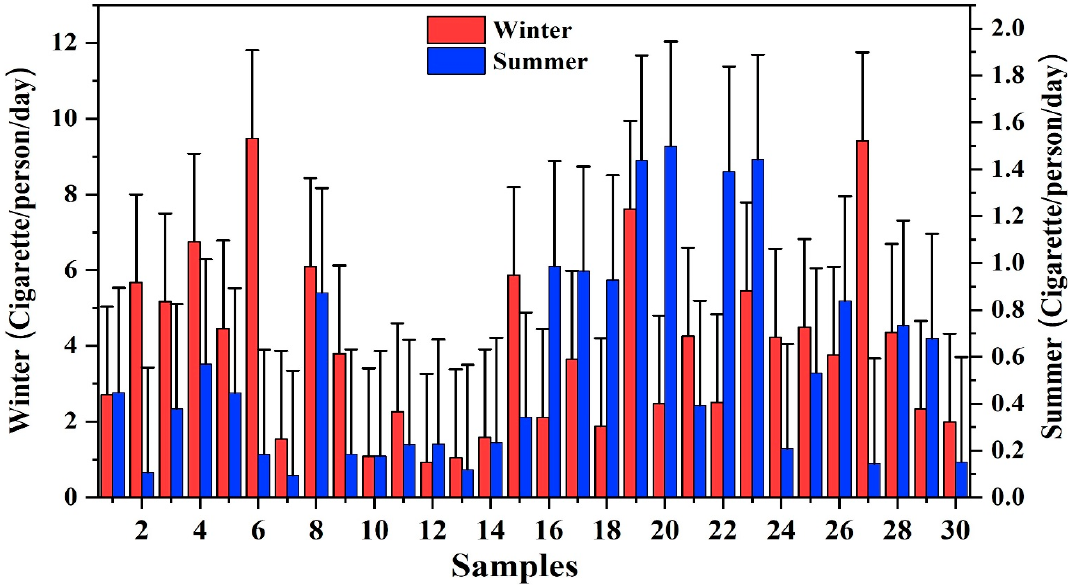
Figure 3. The amount of EPFR exposure equivalent to the number of cigarettes per person per day in Lahore in winter and summertime sampling, 2019 .